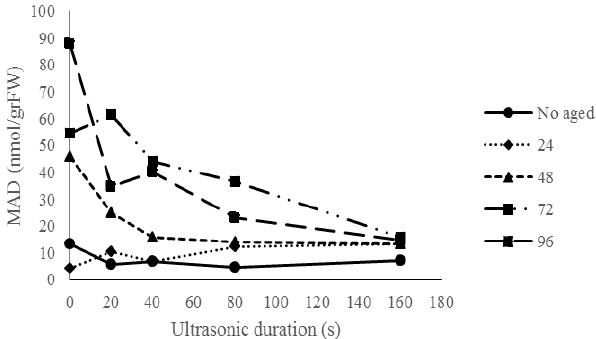
Fig. 2. Interaction effects of aging (hour) and ultrasonic assisted seed priming (seconds) on the MAD activity of Silybum marianum seeds